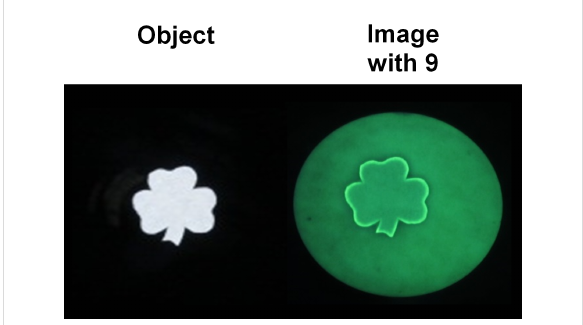
Figure 7: Backlit shamrock object and fluorescence image (excited at 366 nm) on paper containing 6 , 9 and Na 2 CO 3 , following writing with 254 nm light for 16 min. The filter paper diameter is 11.0 cm. Photo- graph reprinted from [85], Copyright (2015) The Royal Society of